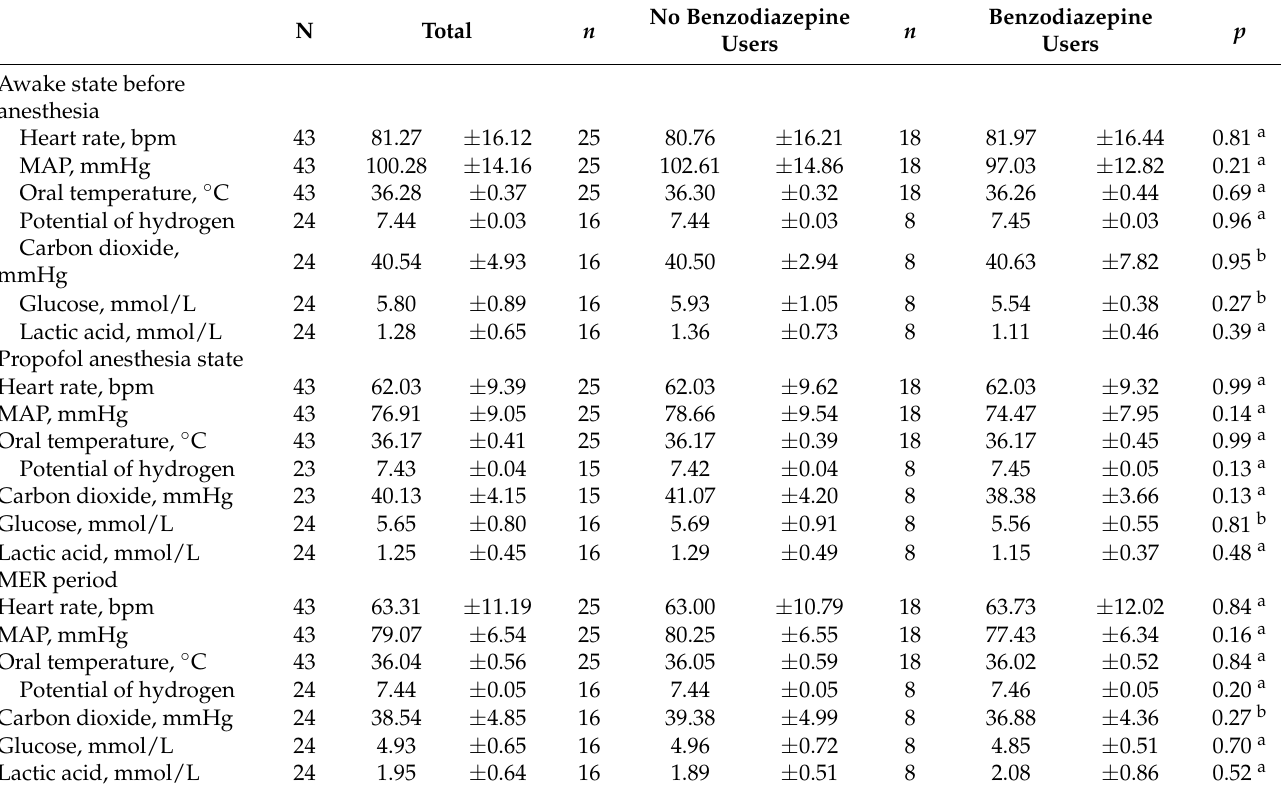
Table 2. Comparison of vital signs and blood gas analysis results of the two groups of patients with Parkinson’s disease in three stages during deep brain stimulation in the subthalamic nucleus.